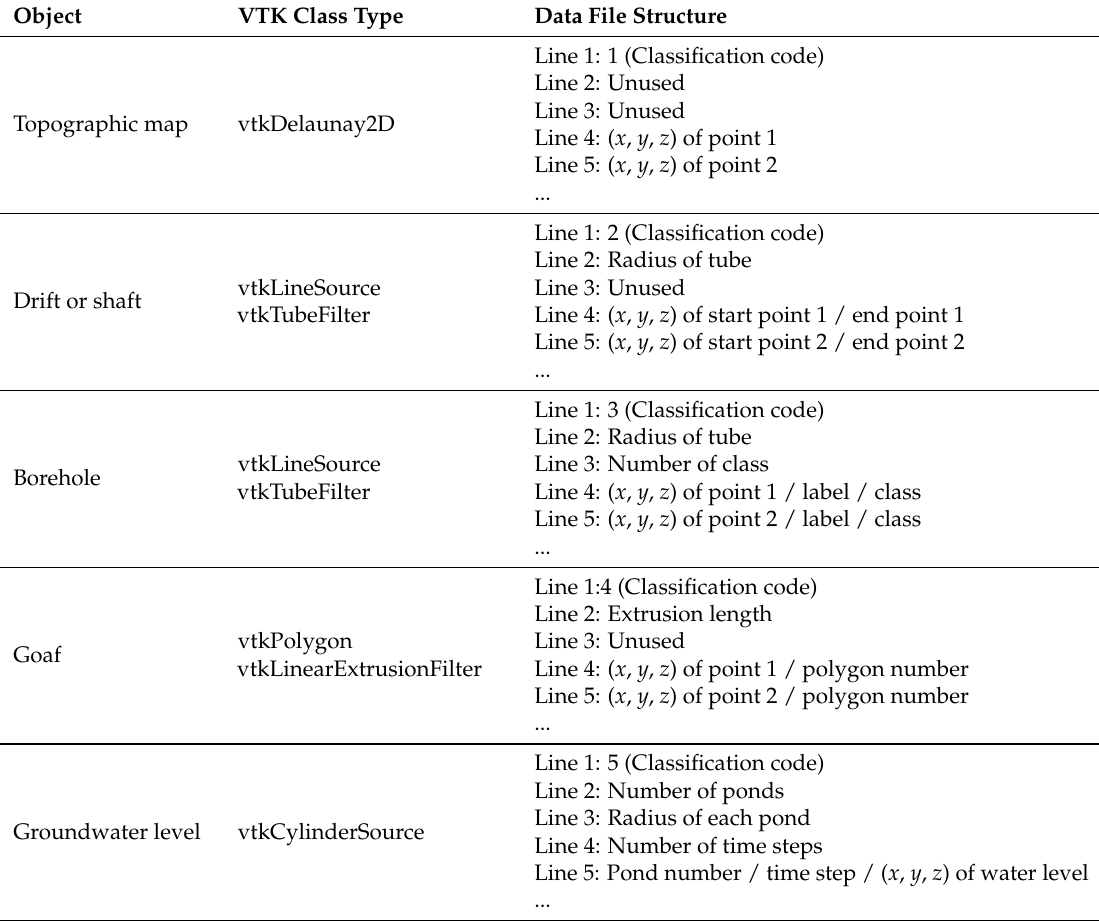
Table 2. Design of 3D objects in